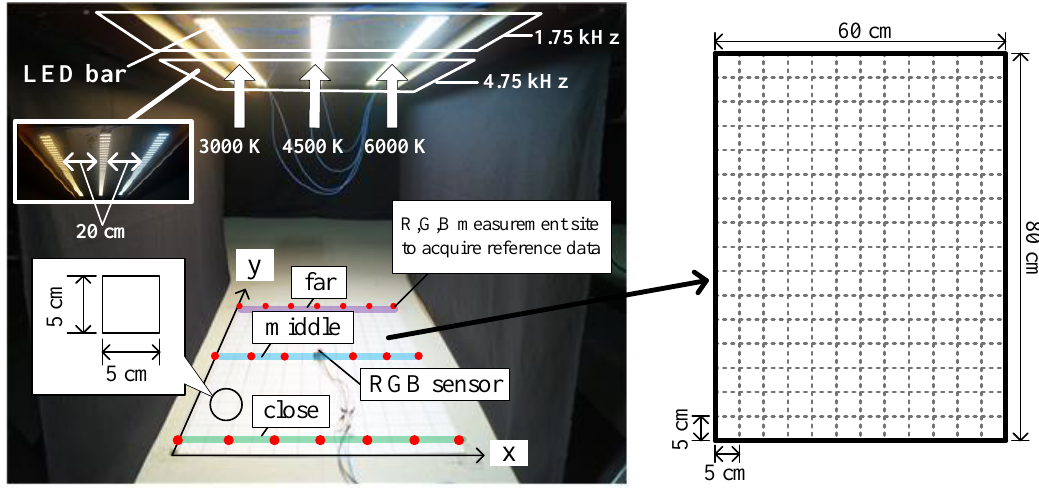
Figure 1. Indoor-environment simulator used in this study and size of testbed [24].